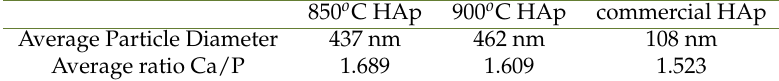
Table 3. Average particle diameter and the ratio Ca/P of the 850 o C HAp, 900 o C HAp, and commercial HAp.